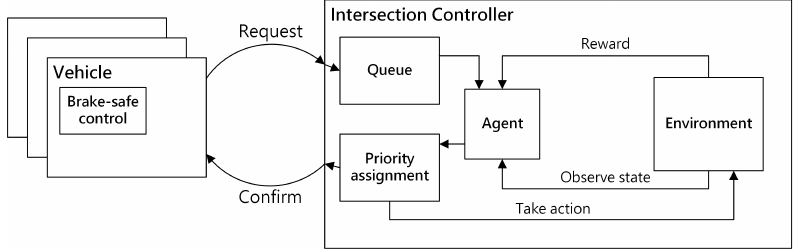
Figure 2. Proposed system architecture.